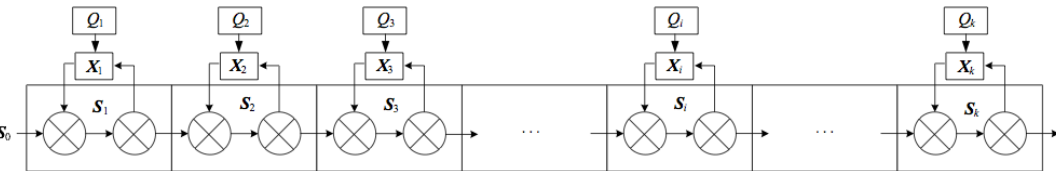
Figure 2. A generalized scheme of the multistage drying process of a multilayer mass of phosphate pellets moving through successively installed k -th local vacuum chambers of a horizontal grate machine.